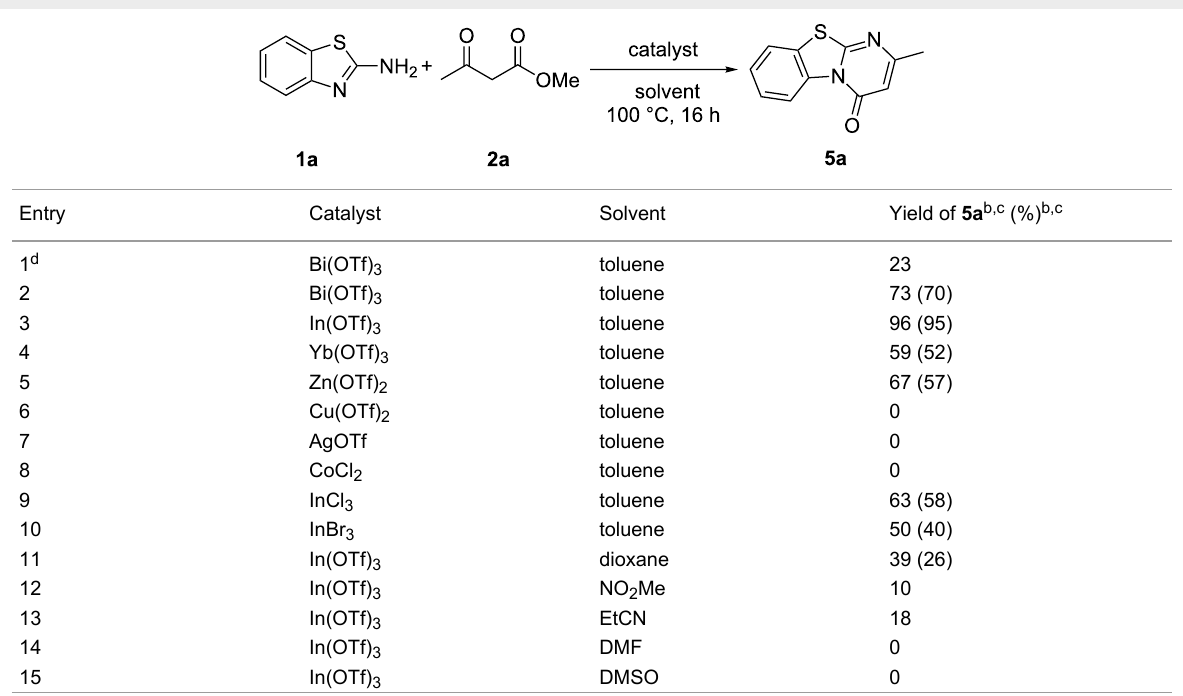
Table 2: Optimization parameters for the synthesis of benzo[4,5]thiazolo[3,2- a ]pyrimidin-4-ones 5a . a